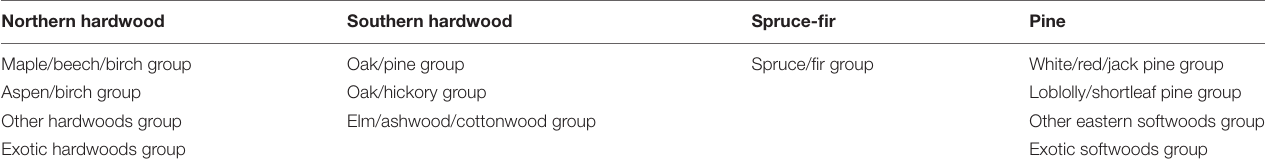
TABLE 1 | Forest Inventory Analysis (FIA) forest types (i.e., the entries in the table) were grouped into one of four broader categories (northern hardwood, southern hardwood, spruce-fir, or pine) for the calculation of biomass nutrient uptake. Northern